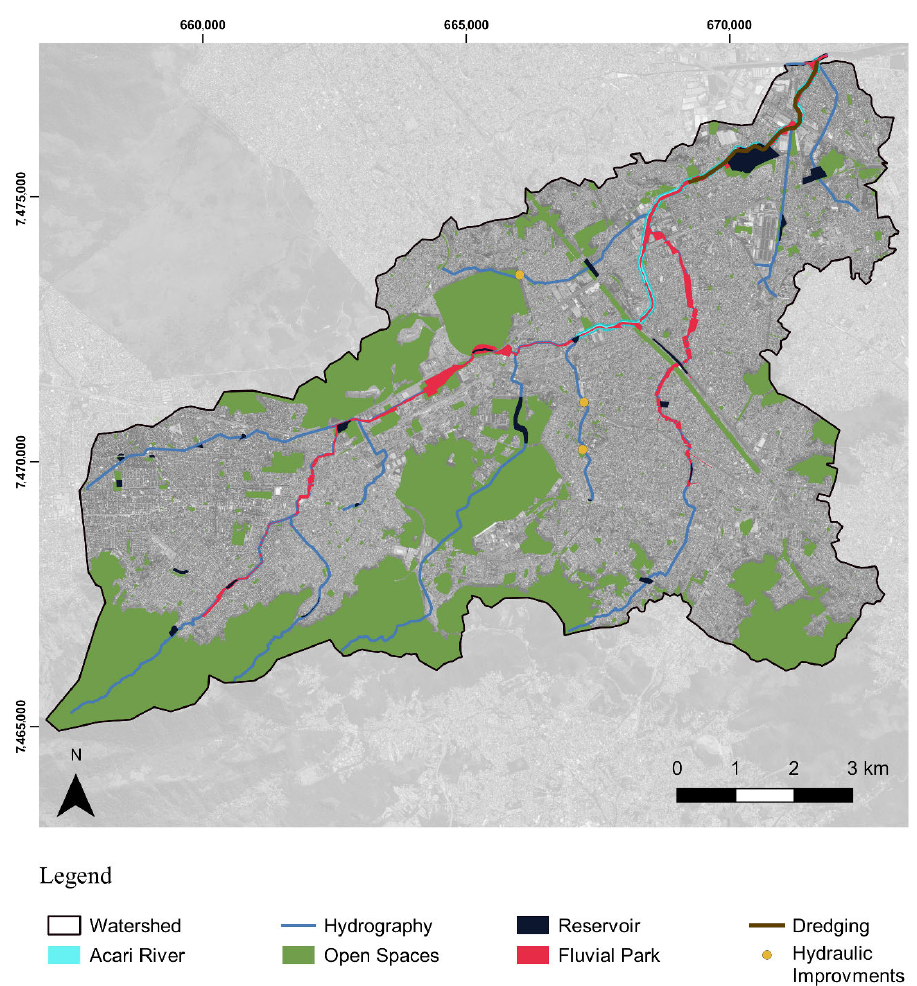
Figure 8. Flood control design in the watershed supported using open spaces.